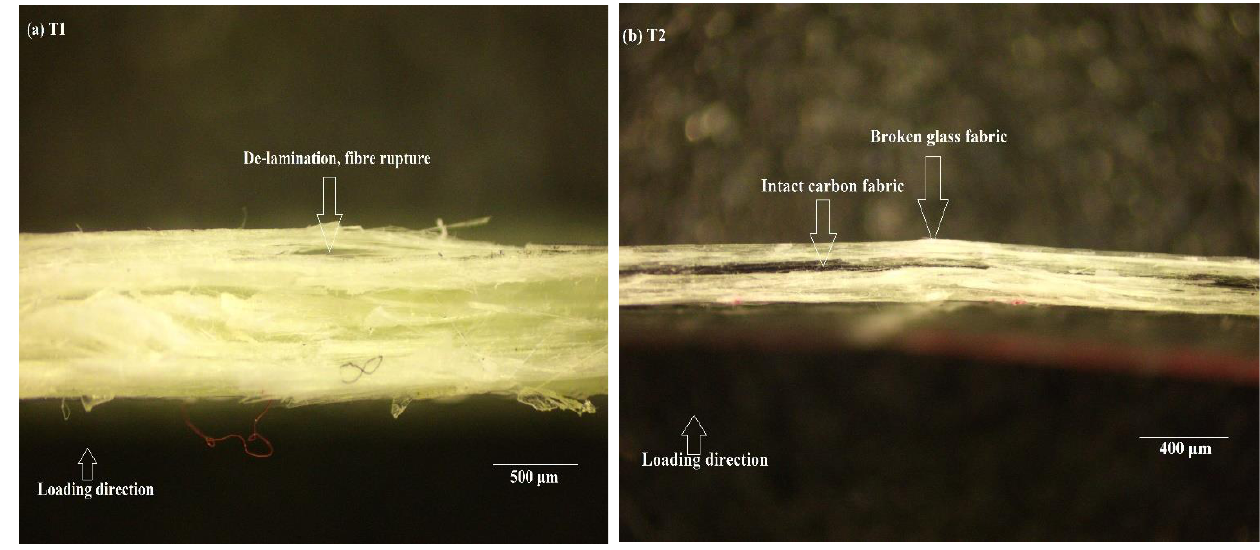
Figure 6. Magnified image of damaged cross-section of T1 ( a ) and T2 ( b ).